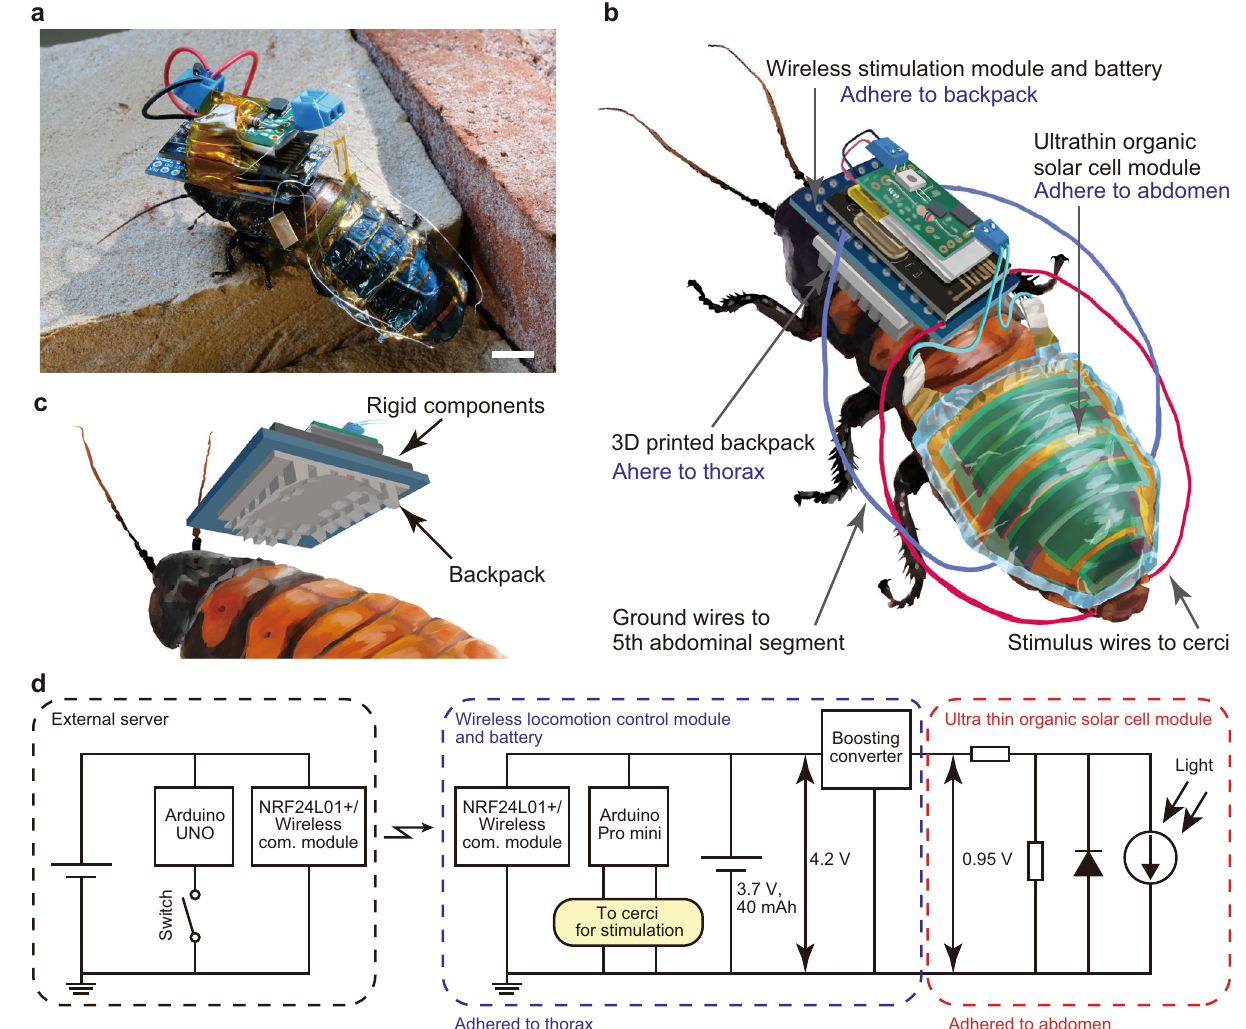
Fig. 1 Rechargeable cyborg insects with an ultrasoft organic solar cell module. a Photograph of a cyborg insect using G. portentosa . Scale bar, 10 mm. b Schematics of cyborgs. c Schematics of mounting rigid components onto the thorax with the assistance of a 3D-printed backpack. d Circuit diagram of the system of the wireless locomotion control module and rechargeable power